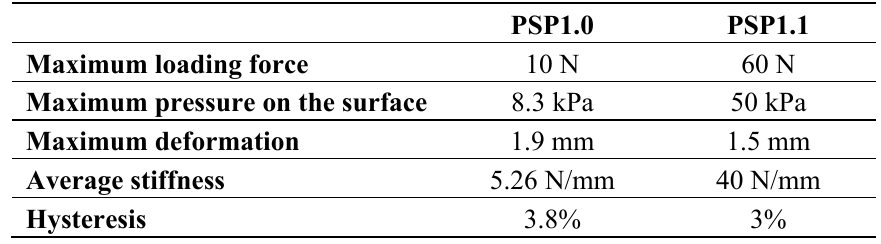
Table 1. Main features of the PSP1 prototypes: maximum loading force, maximum pressure, maximum deformation, average stiffness, and maximum hysteresis expressed in percentage of the full-scale range of the input (values are extracted from